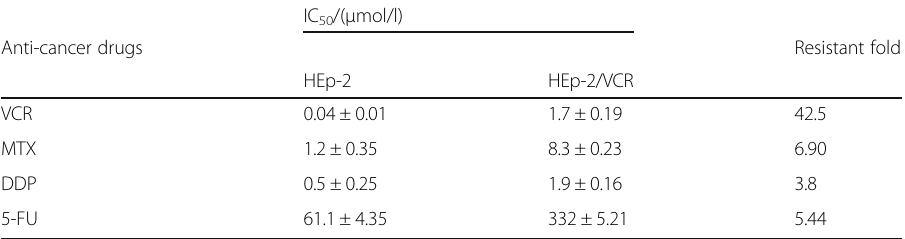
Table 2 Comparison of the IC 50 values for HEp-2 and HEp-2/VCR cells exposed to 4